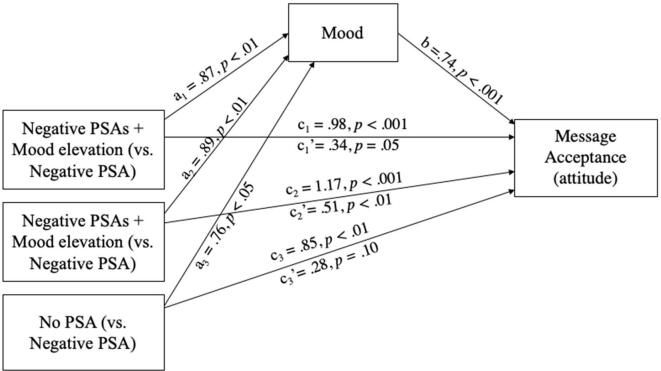
Mediation analysis, Study 1.